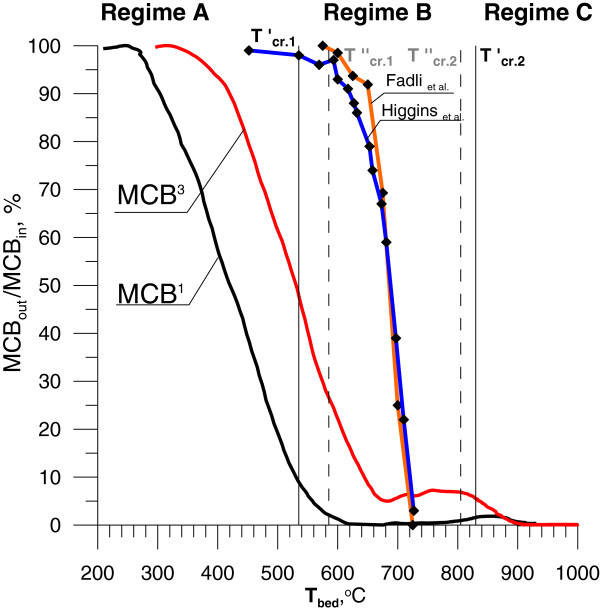
Degree of decomposition of chlorobenzene at different temperature (1 - 900 ppm of MCB,3 – 3650 ppm MCB, MCBin and MCBout are the inlet and outlet concentration of chlorobenzene respectively).